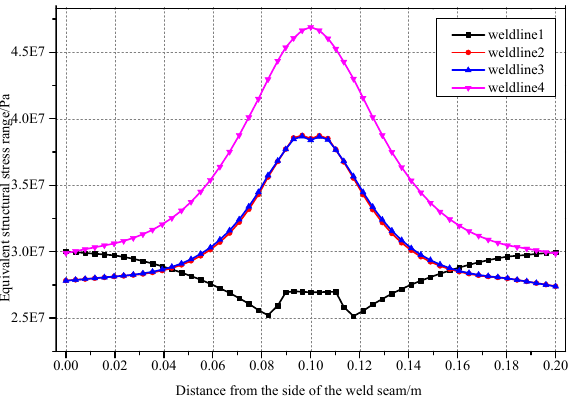
Figure 15. Equivalent structural stress of weld seams of bridge deck with double-sided weld seam.